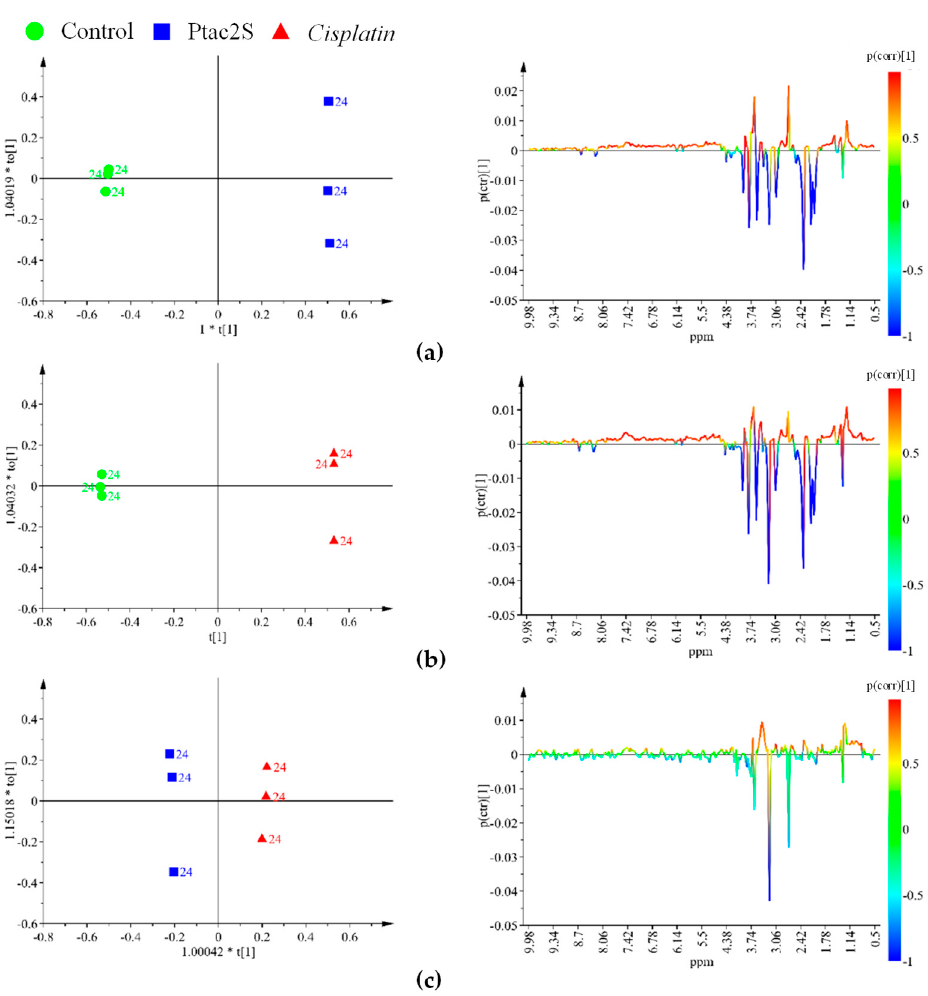
Figure 5. OPLS-DA score plot ( left panel) and corresponding coefficient plot ( right panel) of the 600 MHz 1 H-CPMG-NMR spectra (Pareto scaled) of SKOV-3 cells aqueous extracts obtained from different pairwise groups (controls, Ptac2S, and cisplatin) at 24 h. ( a ) OPLS-DA t[1]/t[2] scores scatter plot (three components, 1 predictive + 2 orthogonal give R 2 X = 0.926, R 2 Y = 1, Q 2 = 0.998). ( b ) OPLS-DA t[1]/t[2] scores scatter plot (three components, 1 predictive + 2 orthogonal give R 2 X = 0.931, R 2 Y = 1, Q 2 = 0.999). ( c ) OPLS-DA t[1]/t[2] scores scatter plot (three components, 1 predictive + 2 orthogonal give R 2 X = 0.745, R 2 Y = 0.998, Q 2 = 0.899).